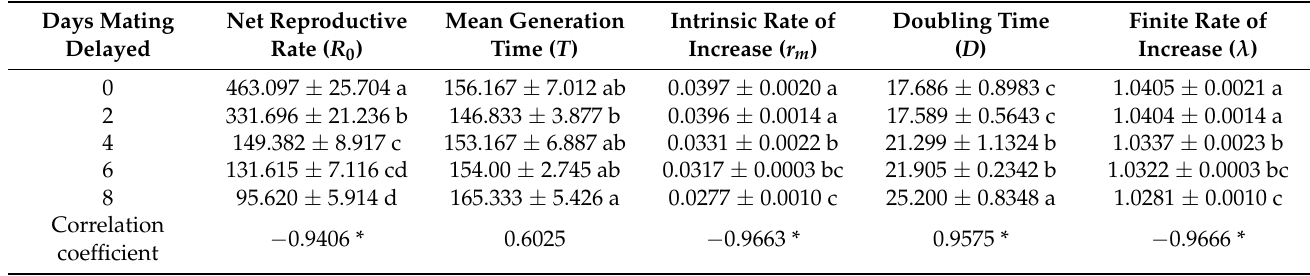
Table 3. Effect of H. vigintioctopunctata female-delayed mating on the life table